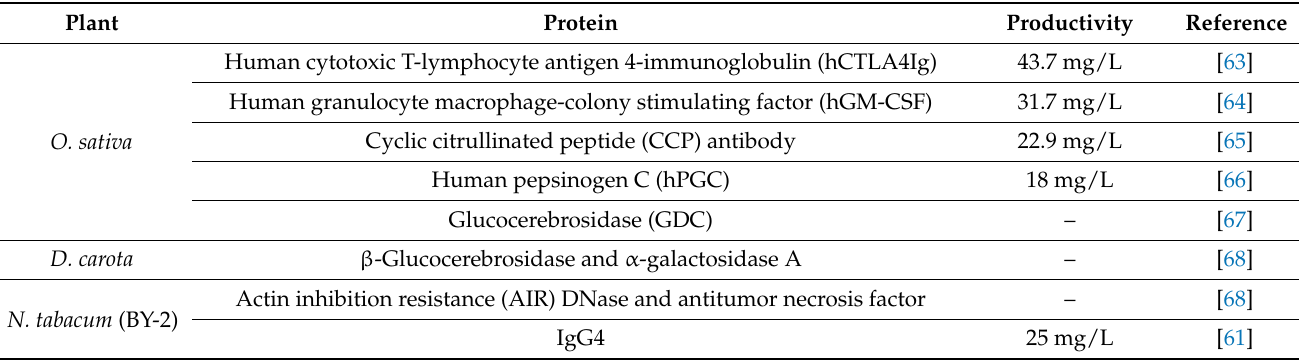
Table 3. Recombinant proteins synthesized in cultured plant